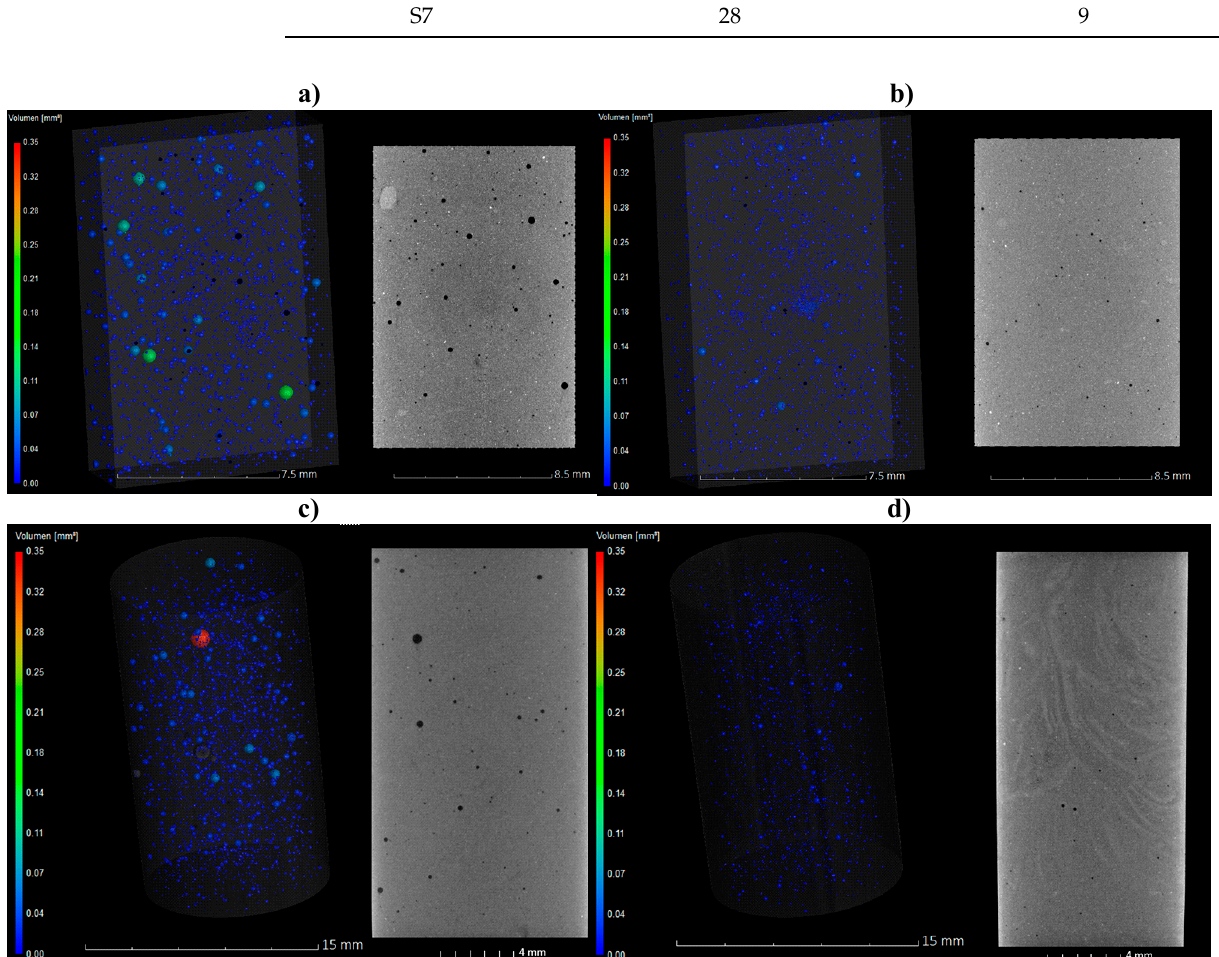
Figure 8. 3D and 2D area void fractions of the only reference CEM II 42.5 R ( a ) after 7 and ( b ) after 28 days compared with the speciments of S7 (Table 3) ( c ) after 7 and ( d ) after 28 days.